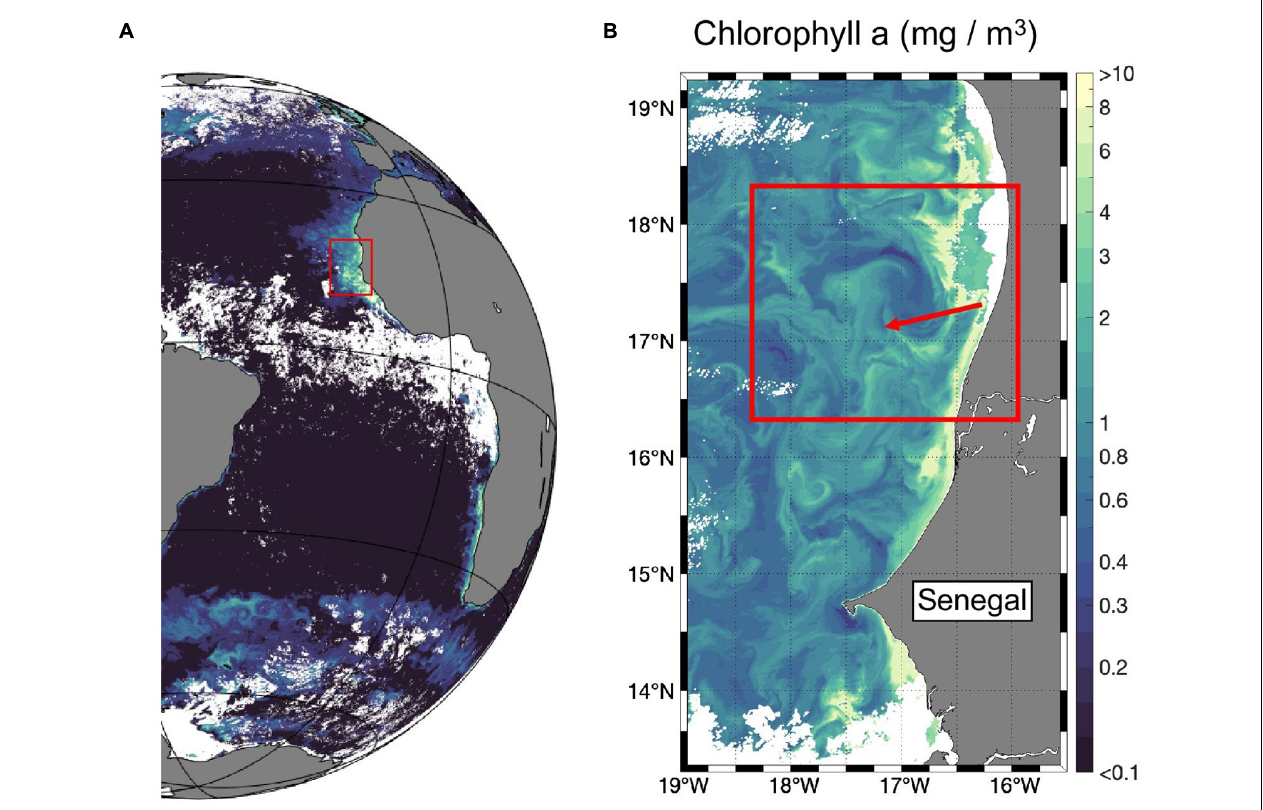
FIGURE 1 | Surface Chl a measured from satellite (A) in February 2018 (monthly mean) and (B) on the 2nd of February 2018. The red box marks the working area including the upwelling